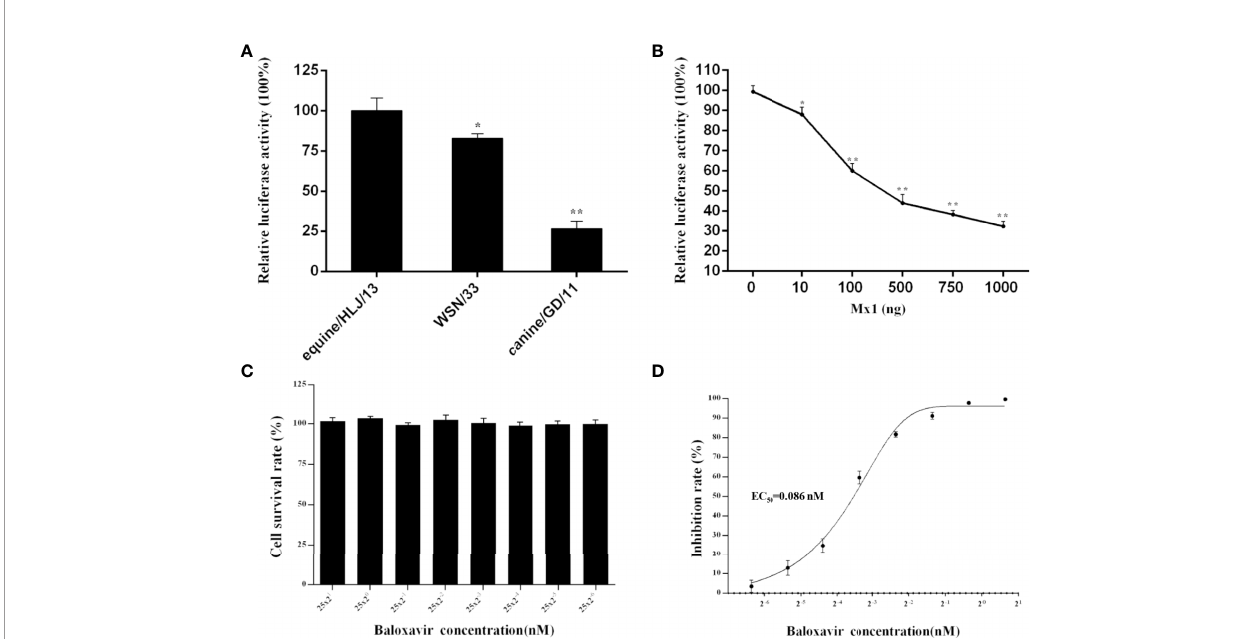
FIGURE 4 | Comparison of the polymerase activity of in fl uenza virus and the inhibitory function of feline Mx1 and baloxavir on the polymerase activity of in fl uenza virus in CRFK cells. (A) The polymerase activity of three representative in fl uenza A virus strains (H1N1 human in fl uenza virus, WSN/1933; H3N8 EIV, equine/HLJ/ 13; and H3N2 CIV, canine/GD/11) in CRFK cells was estimated by dual-luciferase activity experiments. The relative luciferase activity of WSN/33 in CRFK cells was set as 100%. Each experiment was repeated three times. The differences in relative luciferase activity were compared with the WSN/33 group using an unpaired two-tailed Student ’ s t test (* p < 0.05; ** p < 0.01). (B) Inhibition function of feline Mx1 on the polymerase activity of in fl uenza virus in CRFK cells. Increasing amounts (0 ng, 50 ng, 100 ng, and 200 ng) of pCAGGS-FeMx1 were cotransfected into CRFK cells together with the in fl uenza virus minigenome replication system driven by the feline RNA PolI promoter. The relative luciferase activity subjected to 0 ng pCAGGS-FeMx1 construct was set as 100%. The differences in luciferase activity in other experimental groups were compared with the 0 ng pCAGGS-FeMx1 experimental group. Data are shown as the means ± SD from three independent experiments using an unpaired two-tailed Student ’ s t test (* p < 0.05; ** p < 0.01). (C, D) Inhibition function of baloxavir on the polymerase activity of in fl uenza virus in CRFK cells. (C) The CCK8 assay was used to determine the cytotoxicity of baloxavir (concentrations ranging between 25×2 1 and 25×2 -6 m M) toward CRFK cells. The absorbance of the untreated control was set at 100%, and the treated samples were normalized to this value. Each experiment was performed in triplicate. (D) Twenty-four hours after baloxavir treatment, CRFK cells were transfected with the in fl uenza virus minigenome replication system driven by the feline RNA PolI promoter. Twenty-four hours after transfection, the expression of luciferase was examined by a dual-luciferase reporter assay system. Each experiment was repeated three times. The EC 50 was calculated by GraphPad Prism 6